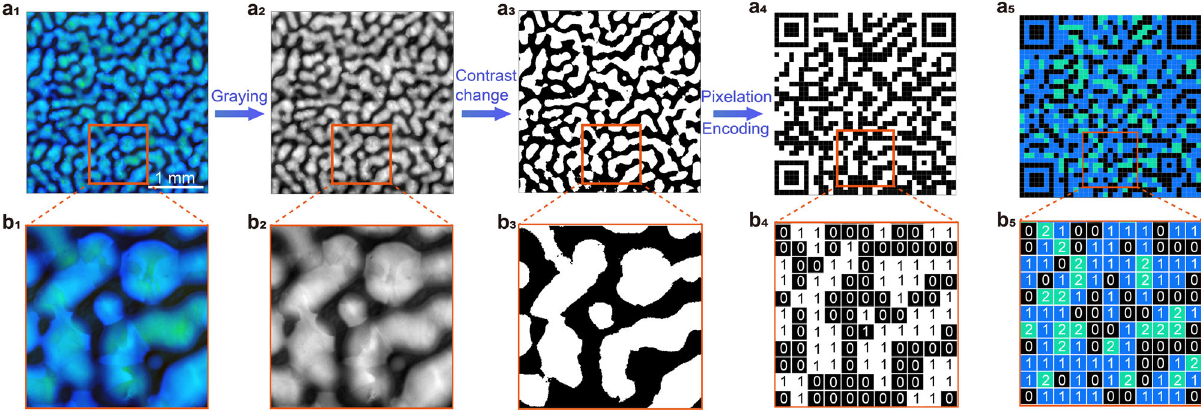
Fig. 5 Binary anti-faking QR codes. a 1 POM image of PS-BPLCs at Stage IV with low magni fi cation. a 2 The image obtained after the gray-level conversion of a 1 . a 3 An image of the binarization of a 2 . a 4 The binary codes obtained from a 3 after pixelation and encoding processes. a 5 Large-scale ternary QR code with a pixel resolution of 37 × 37 encoded from a 1 undergoing ternary and pixelation processes. b 1 – b 3 The magni fi ed image of the orange squared area in a 1 – a 3 . b 4 – b 5 The binary and ternary codes of the orange-squared area in a 4 , a 5 . In binary codes, the “ black ” or “ white ” pixel represents “ 0 ” or “ 1 ” . In ternary codes, the “ green ” , “ blue ” , or “ black ” pixels in a 5 , b 5 represents “ 2 ” , “ 1 ” , or “ 0 ” .